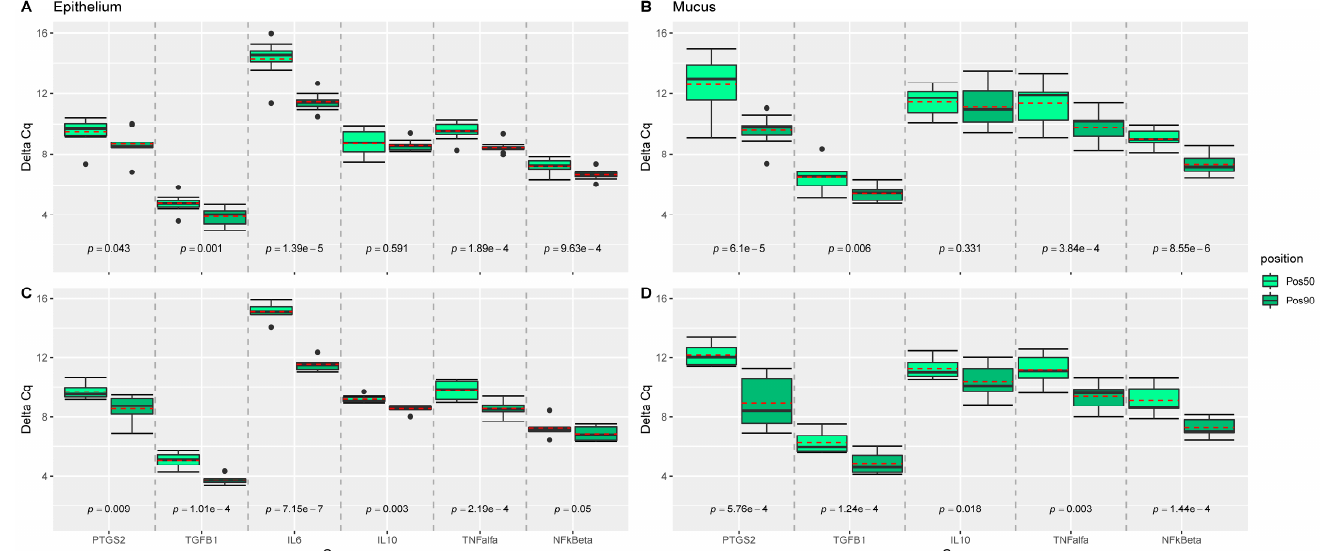
Figure 2. Comparison of ileal position effect (pos50 versus pos90) of epithelium and mucosal samples for each gene. p - values were estimated from mixed effect models with position as fixed and sow and piglet as random effect using the Satterthwaite’s method. Linear mixed effect model analyses were performed for each gene, tissue, and treatment group, separately, and grouped boxplots including all genes were generated: for ( A ) epithelium samples from the LOW treatment group; ( B ) mucosal samples from the LOW treatment group; ( C ) epithelium samples from the HIGH treatment group; ( D ) mucosal samples from the HIGH treatment group. Pairwise comparisons are separated by grey dashed lines. Mean values per group are indicated by red dashed lines. n = 18 piglets.